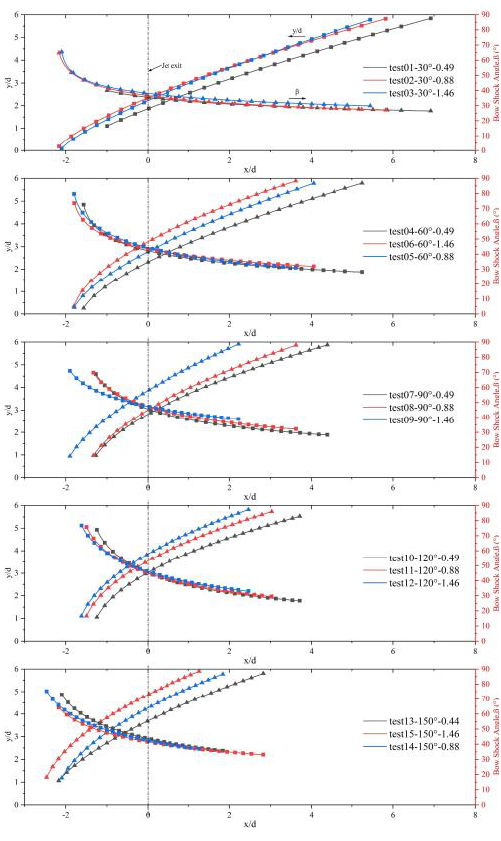
Figure 13. Position and angle of the bow shock.